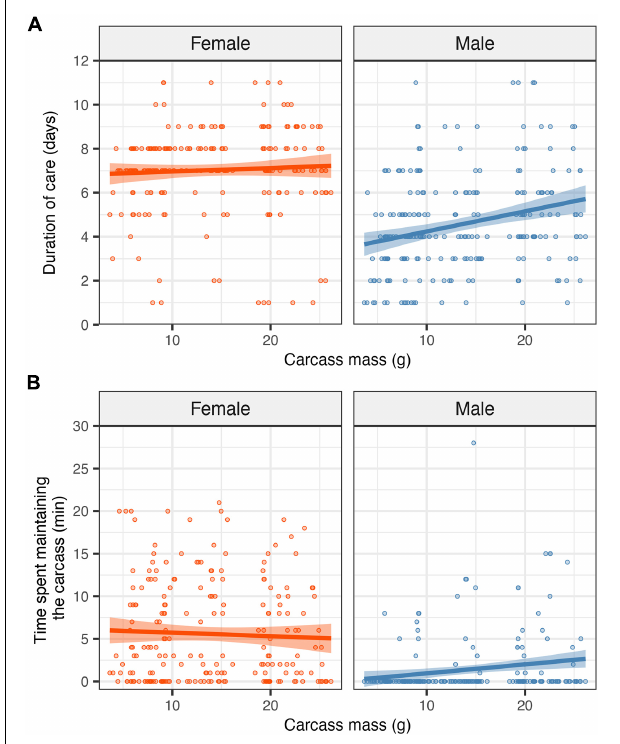
FIGURE 1 | Effects of carcass mass on the duration of female and male parental care (A) and on the time each parent spent on carcass maintenance (B) . Filled circles represent individual data points, lines represent linear regression lines and shaded ribbons the 95% confidence